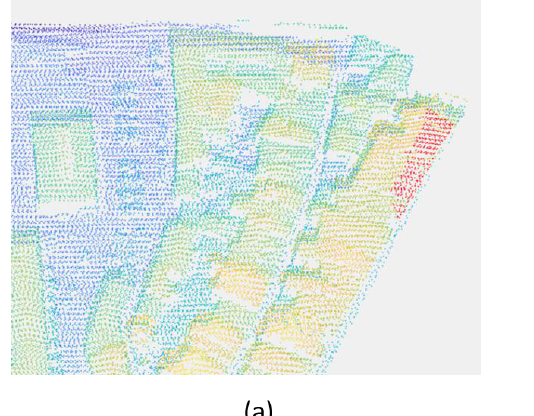
Table 2. Results for the Historic Centre data sample.